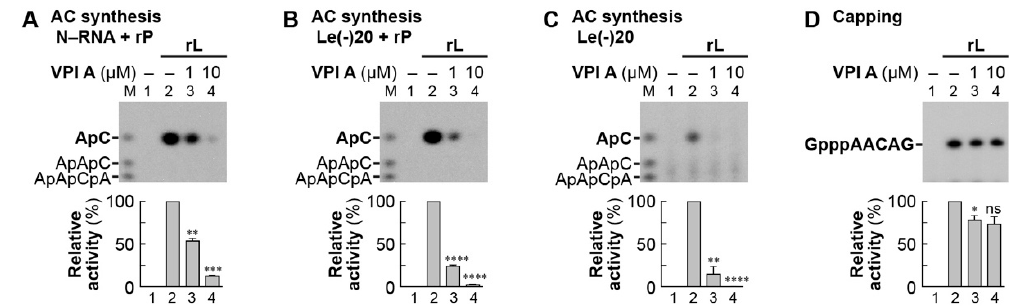
Figure 9. VPI A inhibits terminal de novo initiation of LeRNA synthesis with the VSV L protein. In vitro AC synthesis (first phosphodiester bond formation) by the recombinant VSV L protein was performed with ( A and B ) or without ( C ) the P protein in the presence or absence of VPI A (1 or 10 µM). The N–RNA (A) or Le(-)20 oligo RNA ( B and C ) was used as a template. Calf intestine alkaline phosphatase-resistant RNA products were analyzed by 20% urea-PAGE followed by autoradiography. Lane 1 indicates no L protein. M lane shows 5 ′ -hydroxyl oligo-RNAs with the indicated sequences. In ( D ), in vitro oligo-RNA capping by the recombinant VSV L protein was carried out with [ α - 32 P]GDP and pppAACAG in the presence or absence of VPI A (1 or 10 µM). The graphs show relative activities of AC synthesis ( A – C ) and oligo-RNA capping ( D ), where radioactivities of each product synthesized without and with the L protein (lanes 1 and 2, no drug) were set to 0 and 100%, respectively. Statistical significance was determined by one-way ANOVA (ns, not significant ( p < 0.5); *, p < 0.05; **, p <0.01; ***, p < 0.001; ****, p < 0.0001; compared to control (column 2)).